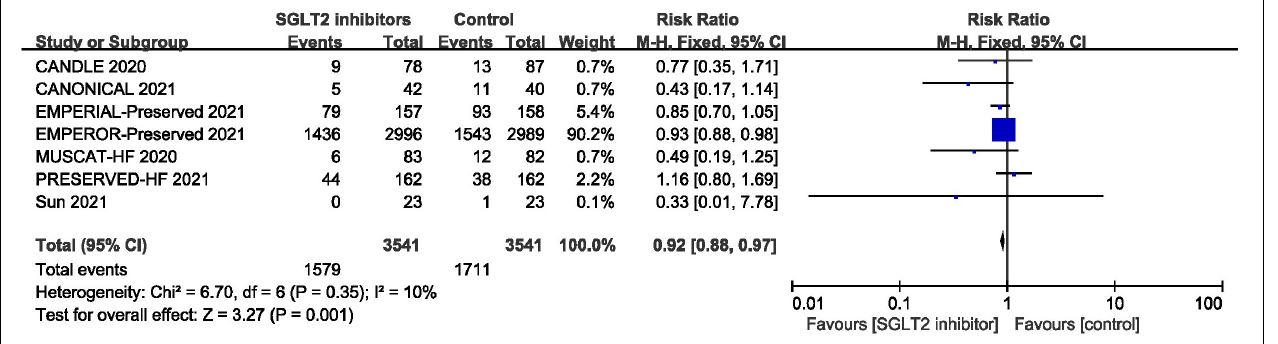
FIGURE 11 | Forest plot displaying the effects of SGLT2 inhibitors vs. placebo for adverse events in HFpEF patients.